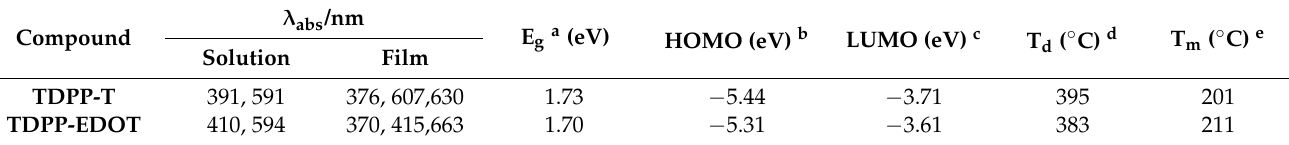
Table 1. Optical, electrochemical, and thermal properties of TDPP-T and TDPP-EDOT .